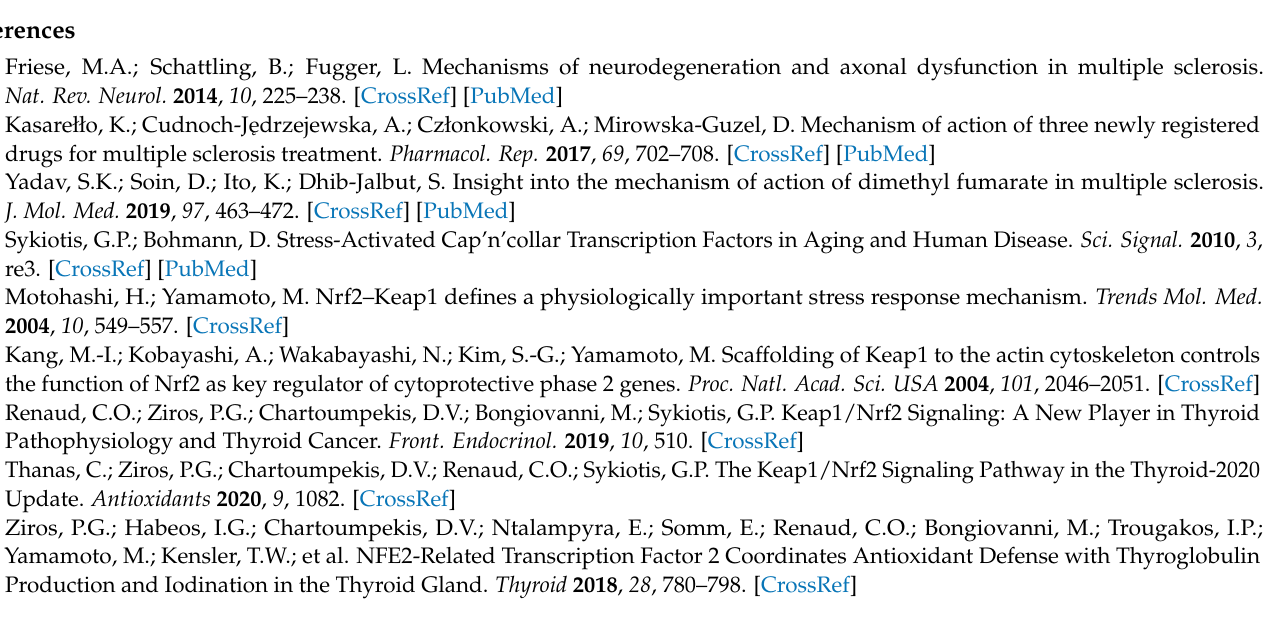
Table S2: Data of patient 9; Table S3: data of patient 15; Table S4: data of patient 62; Table S5: data of patient 97; Table S6: data of patient 103; Table S7: data of patient 121; Table S8: data of patient